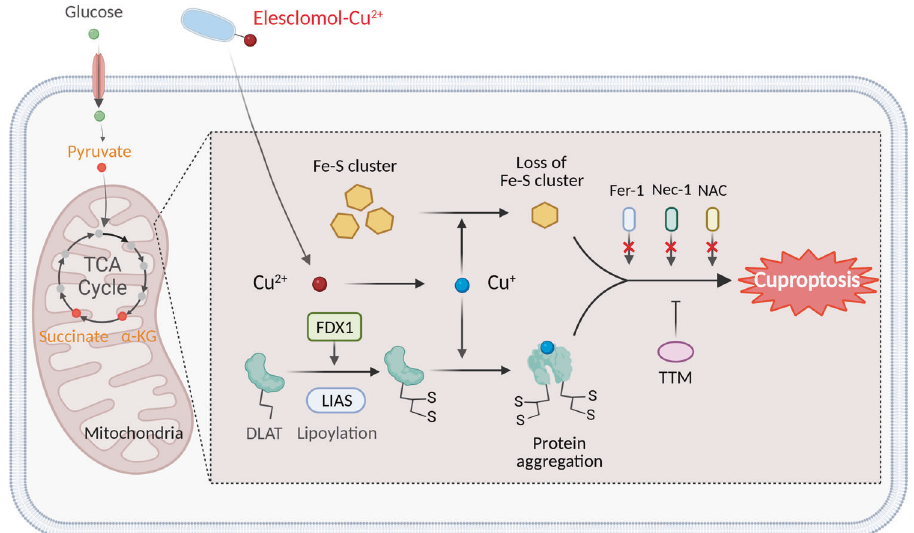
Fig. 2 Schematic model of cuproptosis. Cu ionophores such as elesclomol bind extracellular Cu and transport it to intracellular compartments. Cu then binds to lipoylated mitochondrial enzymes in the TCA cycle such as DLAT, inducing the aggregation of these proteins. FDX1/LIAS is an upstream regulator of protein lipoylation, facilitating the aggregation of mitochondrial proteins and loss of Fe – S clusters. Together, these aberrant processes lead to proteotoxic stress and ultimately cell death. Cu chelators such as TTM inhibit cuproptosis, while inhibitors of ferroptosis (Fer-1), necroptosis (Nec-1), and oxidative stress (NAC) have no effect on cuproptosis. The solid orange circles in the TCA cycle indicate metabolites that are relevant to the lipoic acid pathway. Created with BioRender. α -KG α -ketoglutarate, DLAT dihydrolipoamide S-acetyltransferase, FDX1 ferredoxin-1, Fe – S iron – sulfur, Fer-1 ferrostatin-1, LIAS lipoic acid synthetase, NAC N-acetyl cysteine, Nec-1 necrostatin-1, TCA tricarboxylic acid, TTM